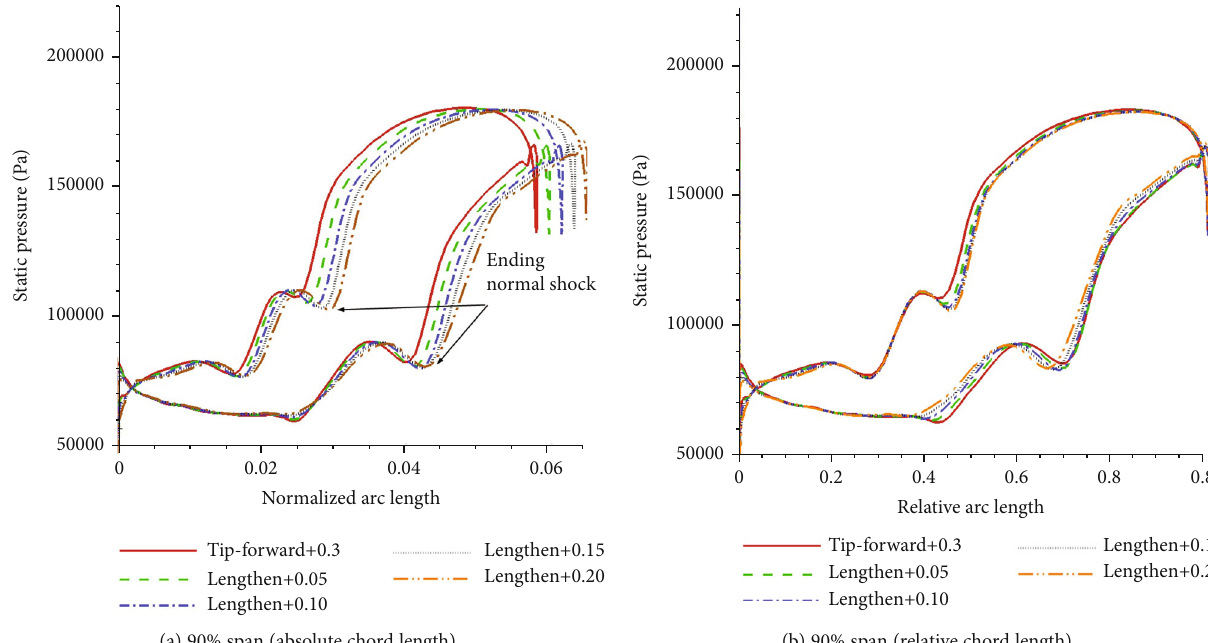
Figure 28: Static pressure distributions on the blade surface for 90% span at the design